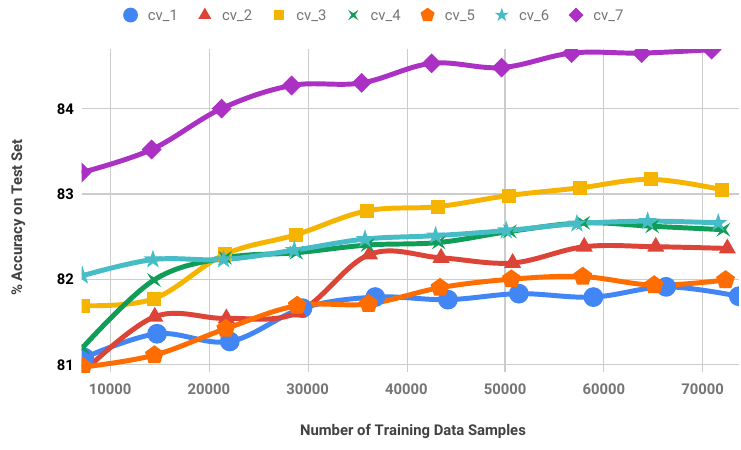
Figure 5. Q 3 accuracy for stratified random selection procedure. A seven-fold cross-validation experiment is performed on CB513 benchmark.